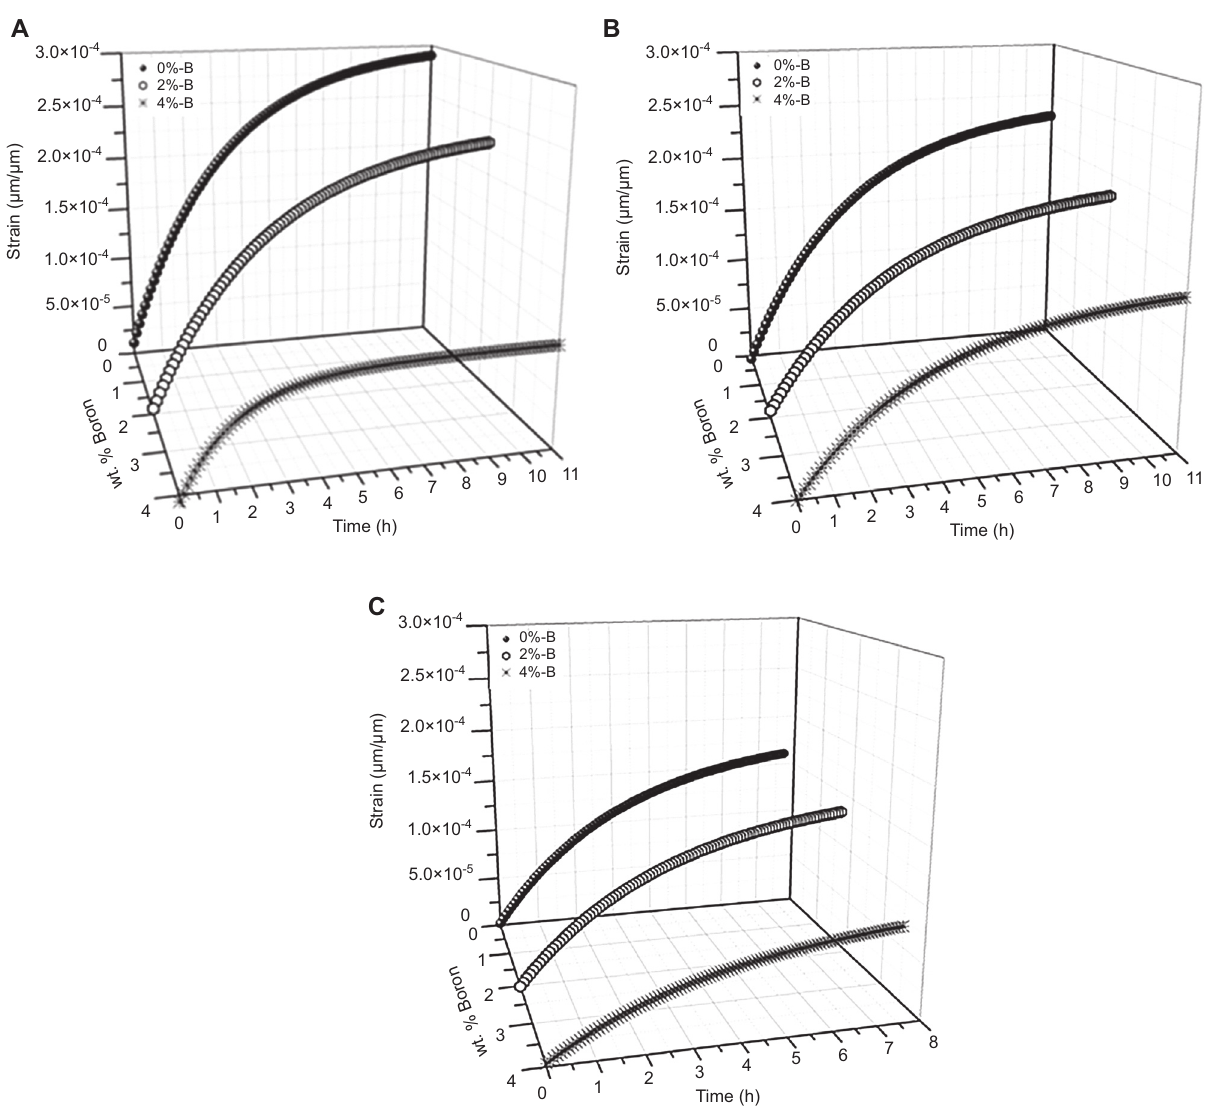
Figure 5 Compressive creep curves of Al-Cu reinforced with diboride particles at 400 ° C and with different loads: (A) 1 N, (B) 0.7 N, (C) 0.5